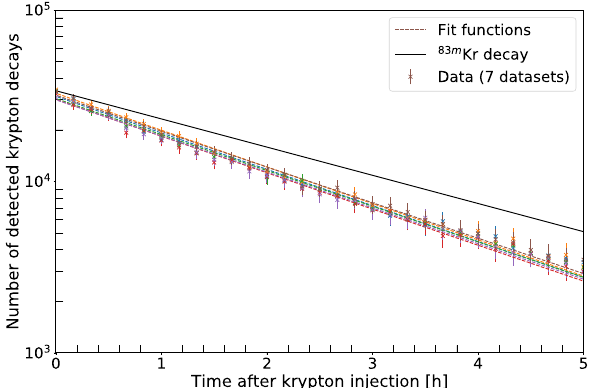
Fig. 5 Number of measured decays per 3 min interval vs. time after injecting 83m Kr into the inner volume. Seven individual measurements areshown.Theblackcurvedescribestheexpectedexponentialdecrease for a fully sealed detector. The observed deviation is caused by a finite leakage flow f which additionally reduces the number of 83m Kr atoms. f can be extracted from a fit of the solution N 1 ( t ) of the differential equations (1) and (2) to the